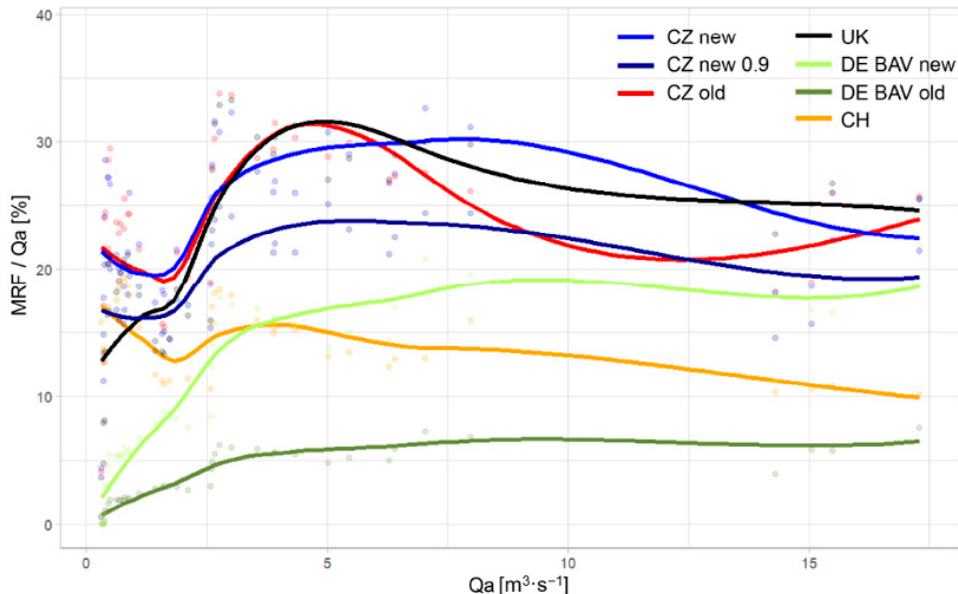
Figure 10. Comparison of MRF values in individual countries in relation to Q a . Vertical axis shows a fraction of the MRF from Q a and horizontal axis shows Q a . CZ—Czech Republic; CZ new—new proposal, CZ new 0.9—new proposal with compensation coefficient reduced to 0.9, CZ old—existing; UK—United Kingdom; DE—Germany, DE BAV new - new proposal, DE BAV old- existing; and